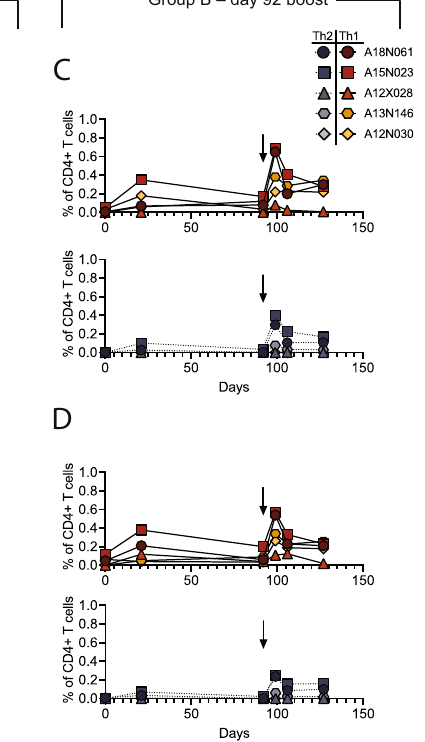
group B. NHP identi fi cation provided correlate with SI Table 1. Percentages are shown as difference between treated samples and DMSO-treated control samples for a single